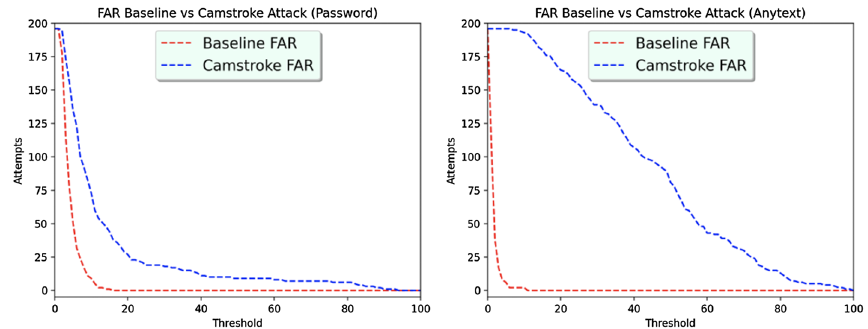
Fig. 18 FAR comparison on password and